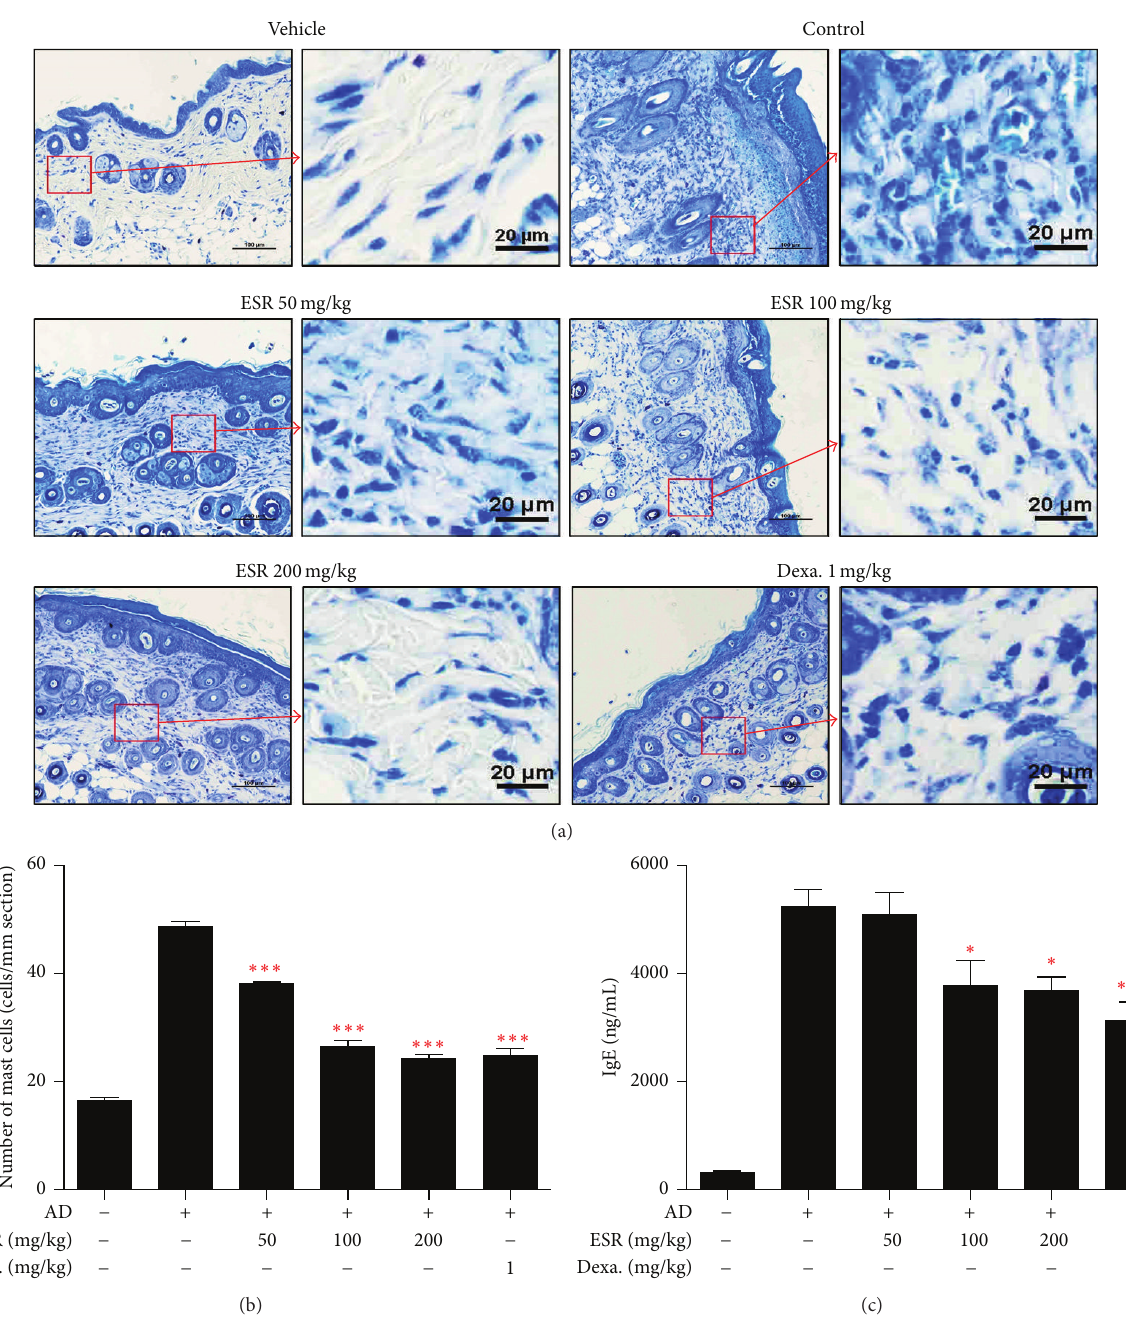
Figure 4: Effects of ESR on mast cell infiltration and serum IgE level in DNCB-induced AD mouse lesions. (a) Toluidine blue stained AD mouse skin lesions (20x, scale bar = 100 𝜇 m) and image of amplification sections (right image of group, scale bar = 20 𝜇 m). (b) Number of mast cells per mm section. Mast cell infiltration in toluidine blue stained sections is expressed as the average total count in five fields of 100 𝜇 m 2 . ∗ 𝑝 < 0.05 , ∗∗∗ 𝑝 < 0.001 versus